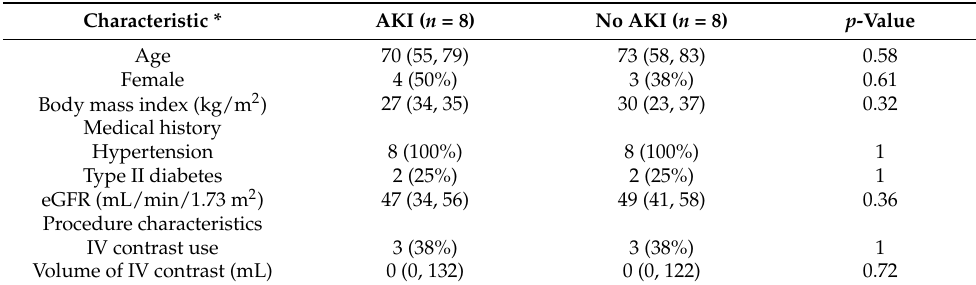
Table 1. Preoperative cohort characteristics.